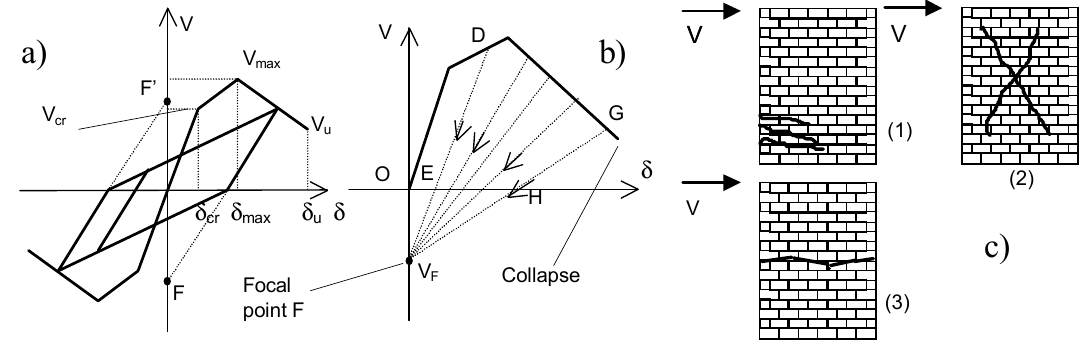
Figure 10. ( a , b ) Hysteretic model for piers and ( c ) failure modes: (1) bending failure; (2) diagonal cracking failure; and (3) sliding shear failure.